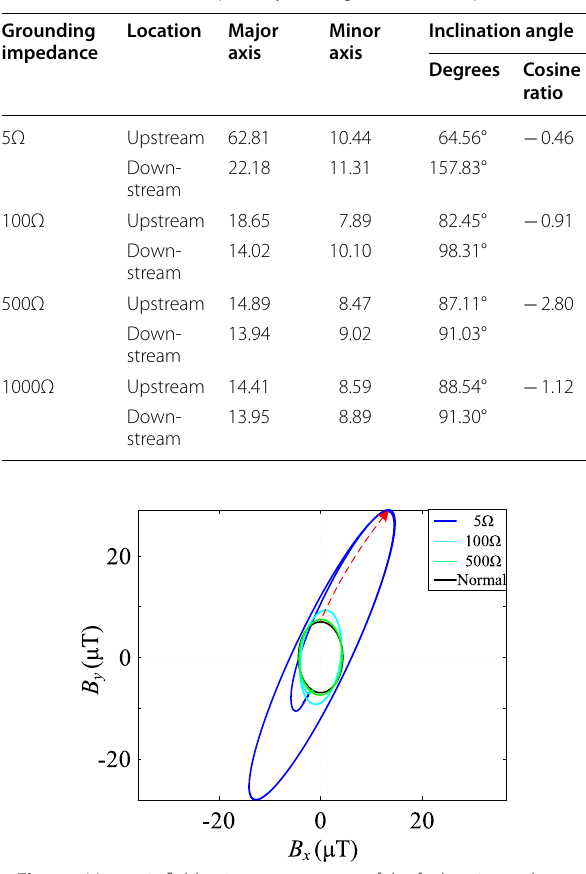
Fig. 17 Magnetic field trajectory upstream of the fault point under different grounding impedances